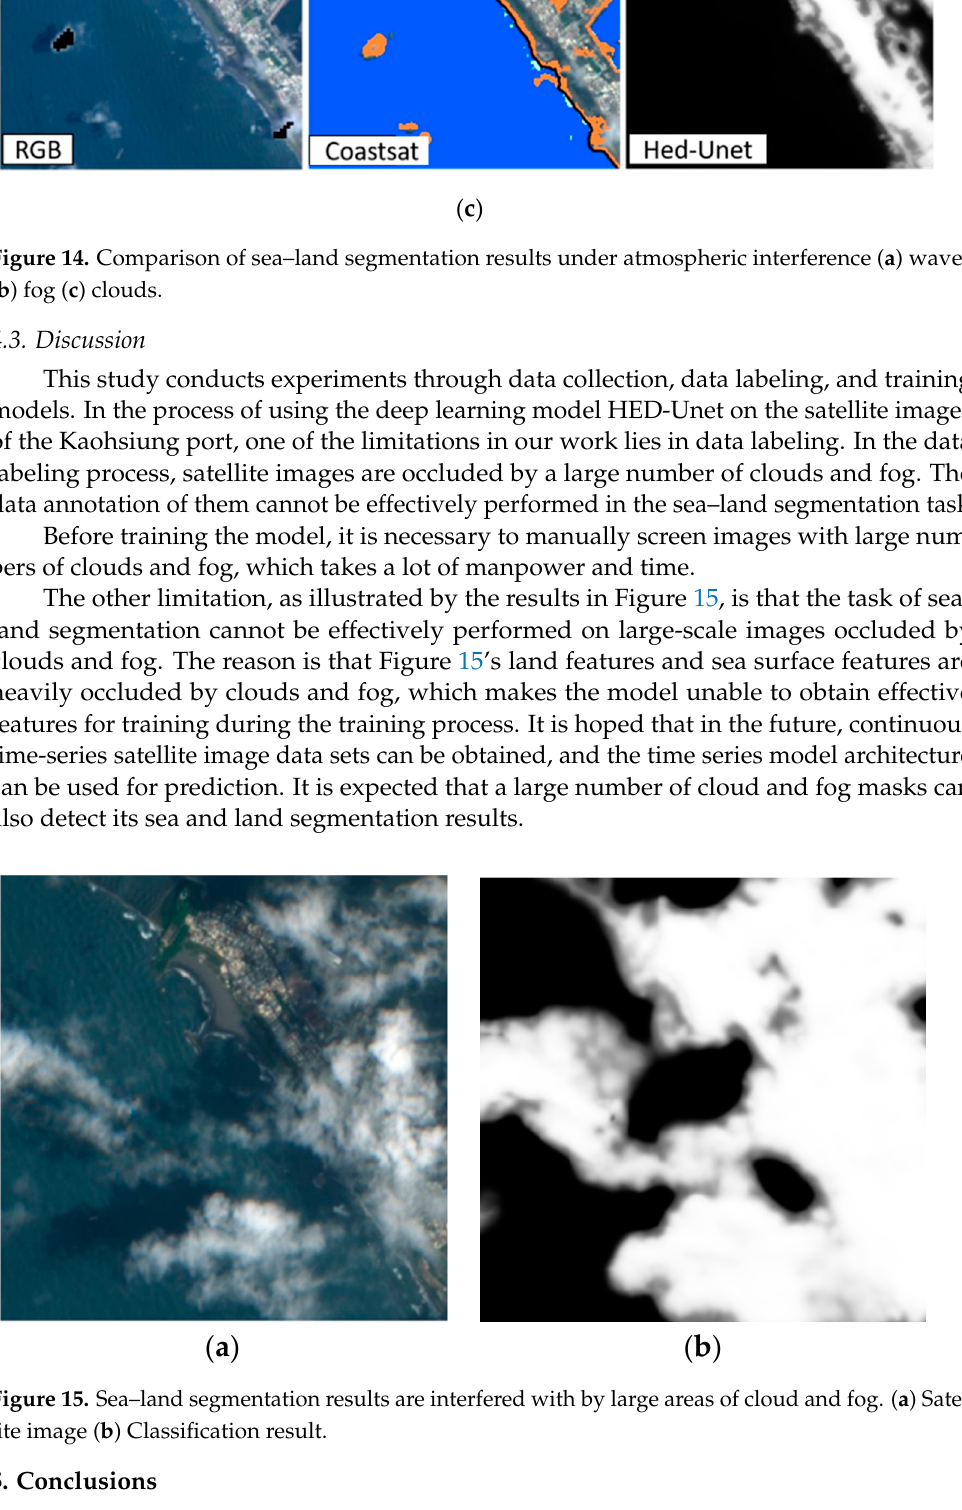
Figure 14. Comparison of sea– l and segmentation results under atmospheric interference ( a ) waves ( b ) fog ( c ) clouds.